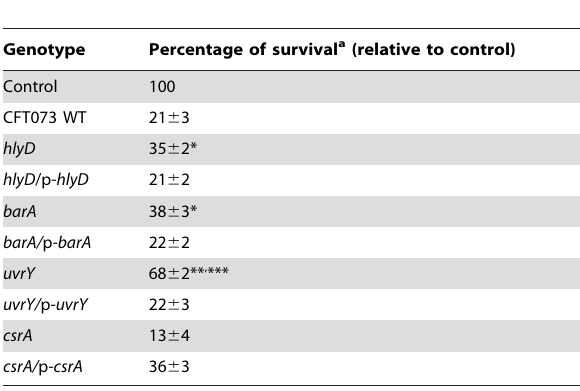
Table 4. Mutation in barA or uvrY reduces and csrA increases the cytotoxic effect to human kidney (HK-2) cells.